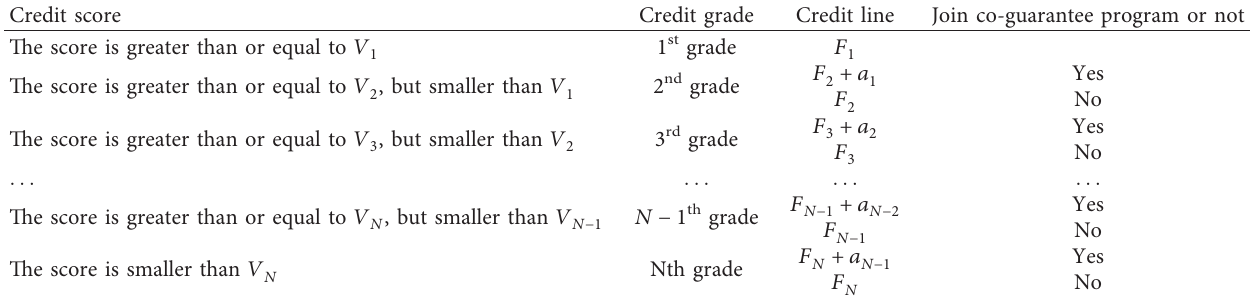
Table 2: Farmer credit rating with N grades and credit lines with/without co-guarantee program. Credit score Credit grade Credit